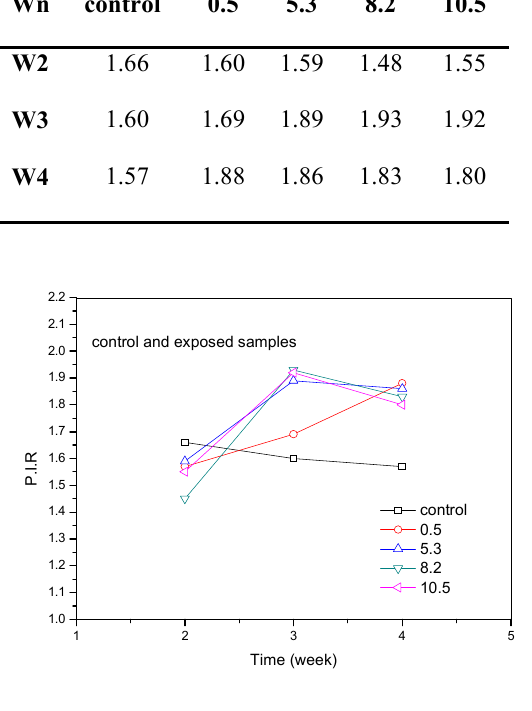
Figure 3. P.I.R vs time for control and exposed groups of Green Mint. Square-black data represents the control